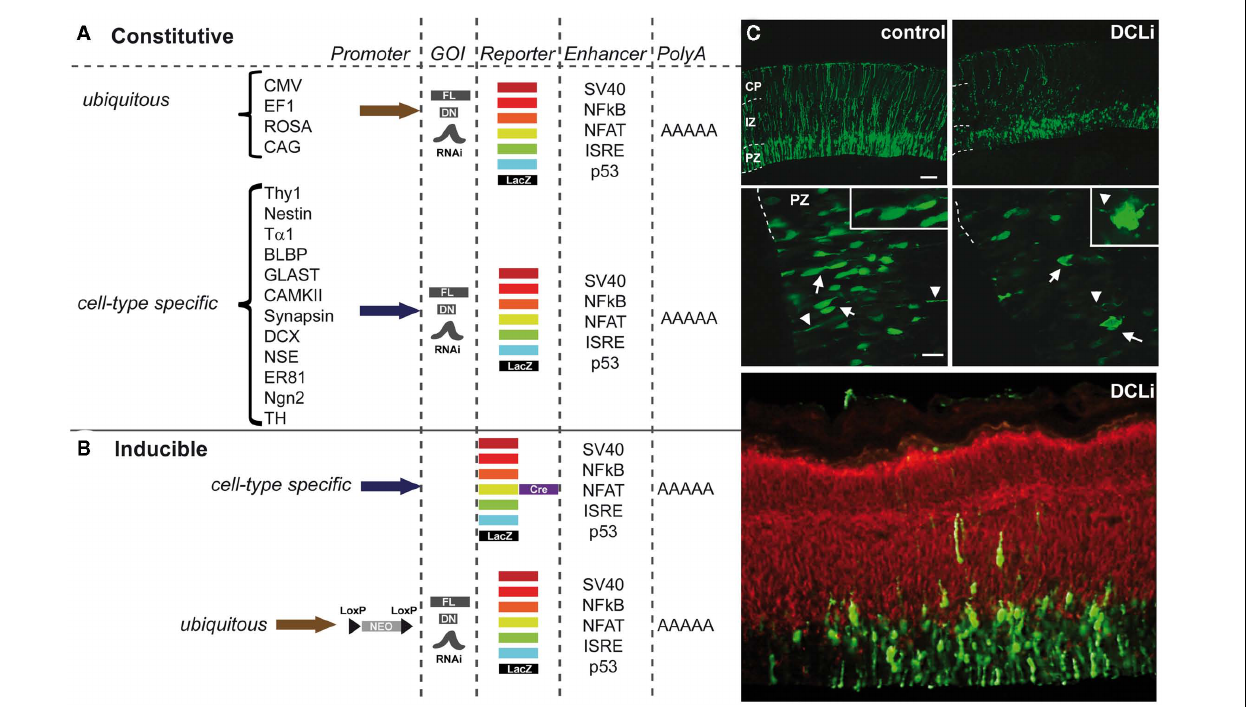
FIGURE 3 | Constructs for use in in utero electroporation (IUE) to direct expression in a four-dimensional way. (A) Schematic representation of the most frequently used constructs that can be constitutively expressed under either a ubiquitous promoter (e.g., CMV, cytomegalovirus; EF1, elongation factor 1; ROSA, ROSA26TATA-less promoter; CAG, chicken actin combined with CMV enhancer) or a cell-type-specific promoter (e.g.,Thy1,THYmocyte differentiation antigen 1 driving expression in axons of neurons; Nestin, neuronal stem cell tubulin neuronal promoter;T α 1, α -tubulin neuronal promoter; BLBP, brain lipid-binding protein radial glial specific promoter; GLAST, glutamate–aspartate transporter radial glial/astrocytic promoter; CAMKII, calcium/calmodulin-dependent kinase II neuronal promoter specific for forebrain; Synapsin, neuronal promoter; DCX, doublecortin neuroblast-specific promoter; NSE, neuron-specific enolase drives expression in neurons and to some extent in glial cells; ER81, ETS family transcription factor driving expression in specific subset of neurons; Ngn2, neurogenin2 driving expression in neurons;TH, tyrosine hydroxylase dopaminergic neuron-specific promoter).These promoters can drive expression of among others full-length (FL)